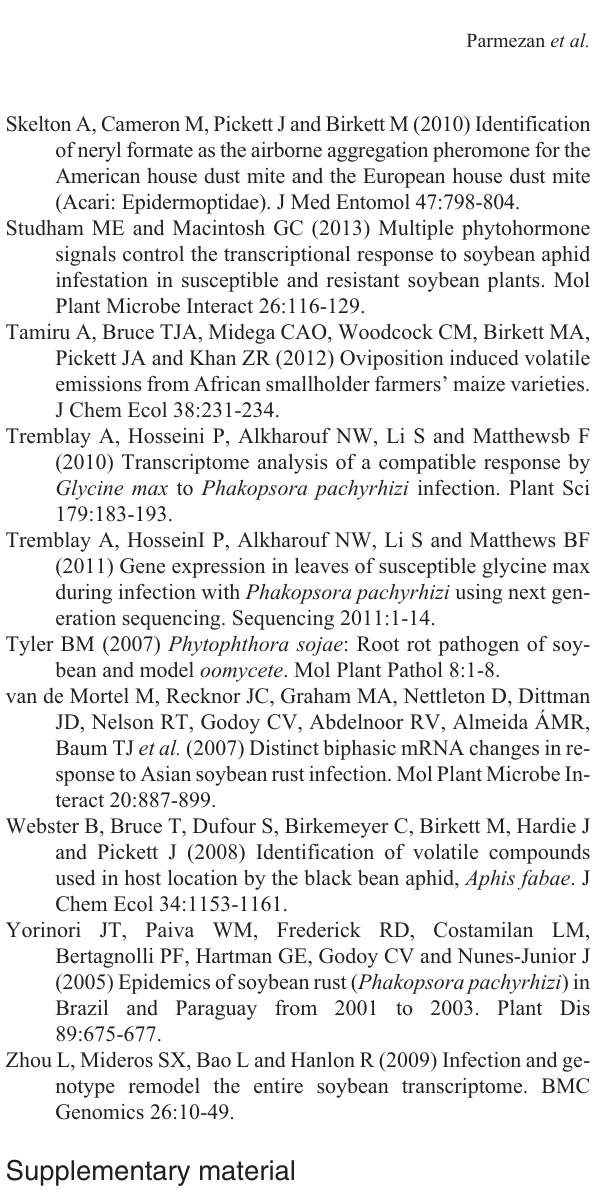
Table S2 - Expression profile of soybean genes after P. pachyrhizi infection. Table S3 - Transcriptional characterization of genes in re - sponse to different soybean